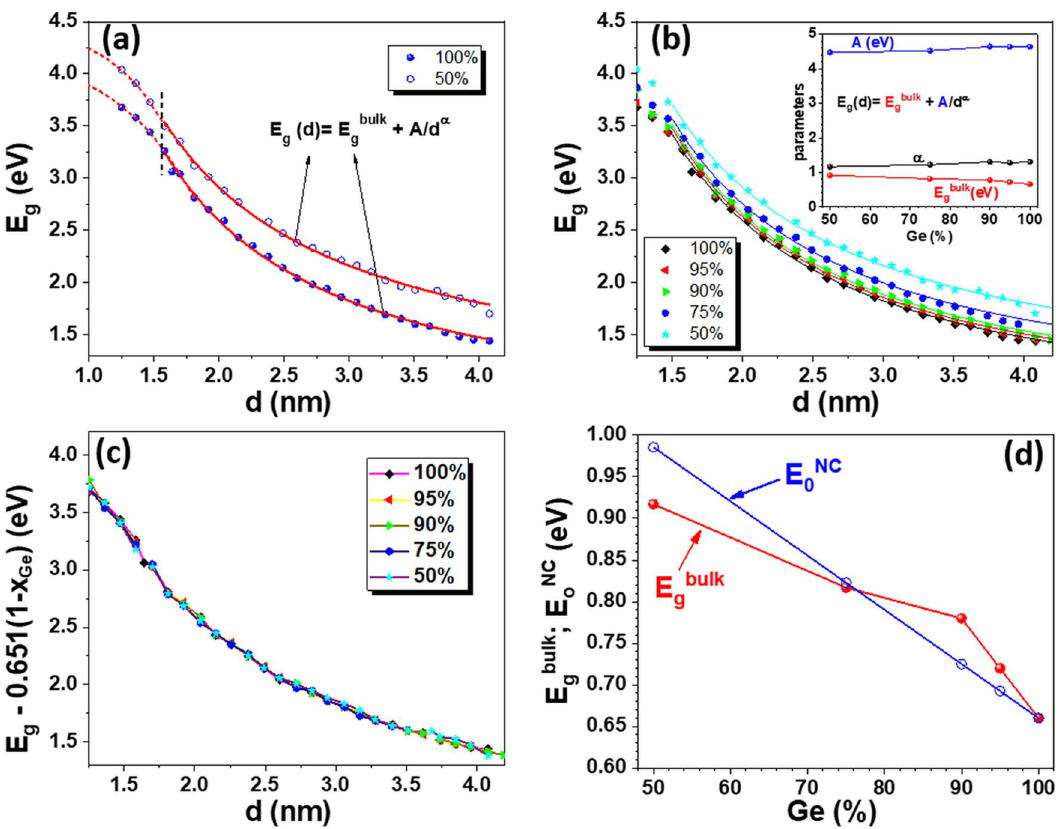
Figure 7. ( a ) and ( b ) Diameter dependence of bandgap E g ( d ) of Ge x Si 1− x NCs for different Ge at.% concentrations obtained by DFT calculations: symbols—calculated points, fit curve—continuous lines with Eq. (1); fit parameters A and α —inset in figure ( b ); E g fit curves show a tendency of upper limitation for diameters smaller than 2 nm—dashed lines in figure ( a ). ( c ) Size dependences of the computed E g ( d ) shifted on vertical by subtracting 0.651(1 − x ) in eV units: E g ( d , x ) = E 0 NC ( x ) + A / d α , E 0 NC = 0.66 + 0.651(1 − x ), A = 4.58 eV, α = 1.25; ( d ) E 0 NC parameter of the cumulative fit of all computed data is compared with E g bulk of Ge x Si 1− x alloys from Ioffe data 50